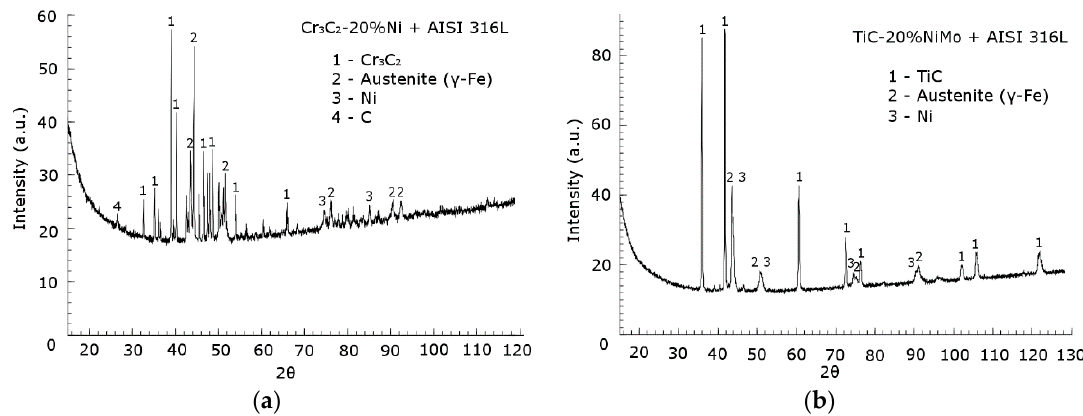
Figure 2. XRD patterns of experimental MAS powders: ( a ) Cr-based powder; ( b ) Ti-based powder.